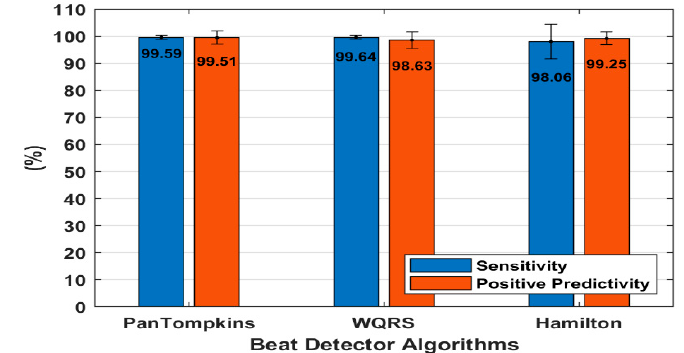
Figure 4. Beat detector algorithm performance on a clean data.